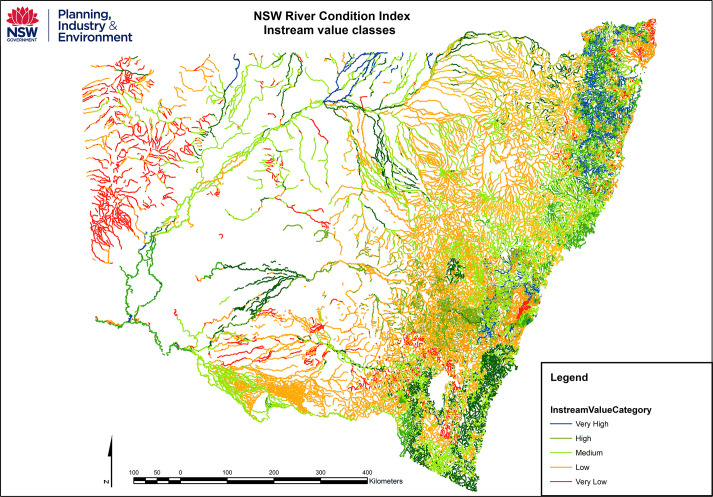
State-wide High Ecological Value Aquatic Ecosystem (HEVAE) assessment that includes River Styles value as one layer.